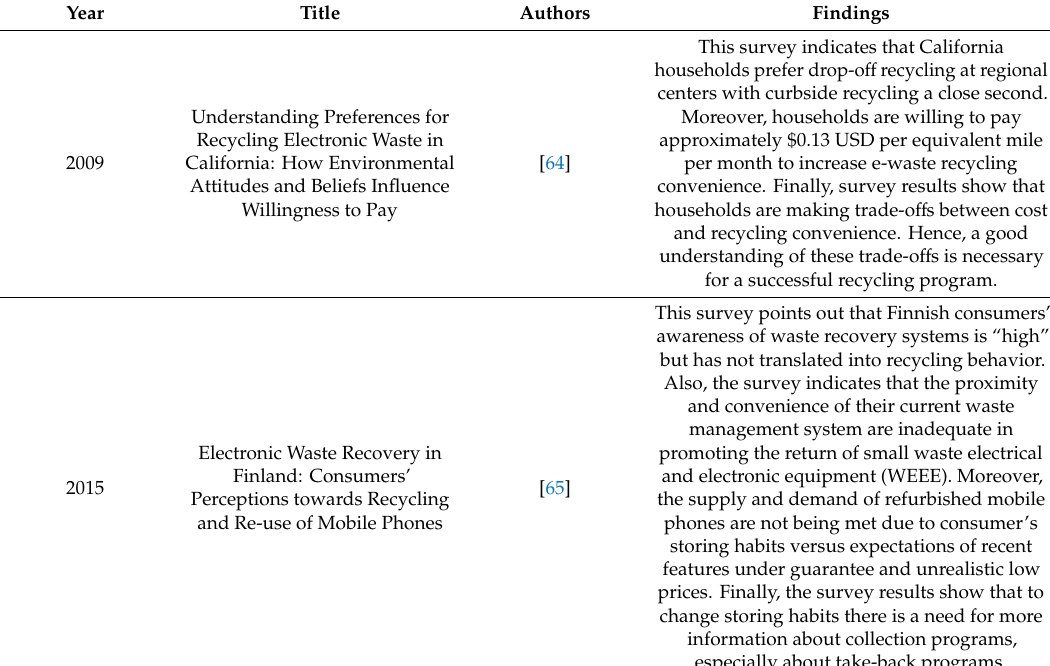
Table 6. Related studies on electronic product consumers